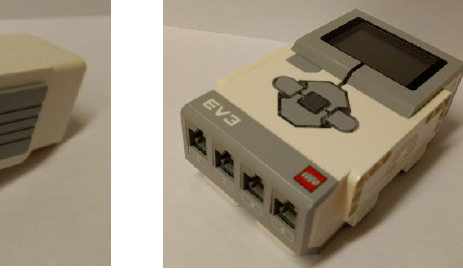
Figure 5. The physical model built with a Lego Mindstorms set.